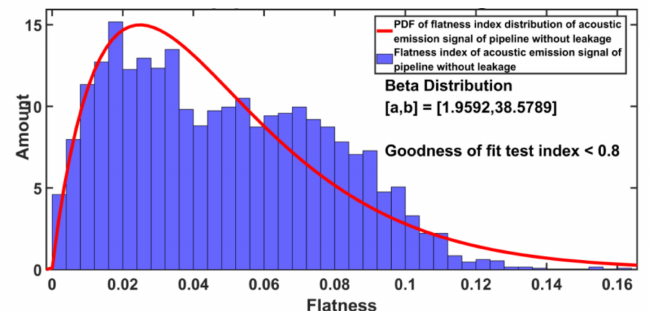
Figure 14. Distribution of the spectral flatness of the acoustic emission signals of WDSs without a leakage.